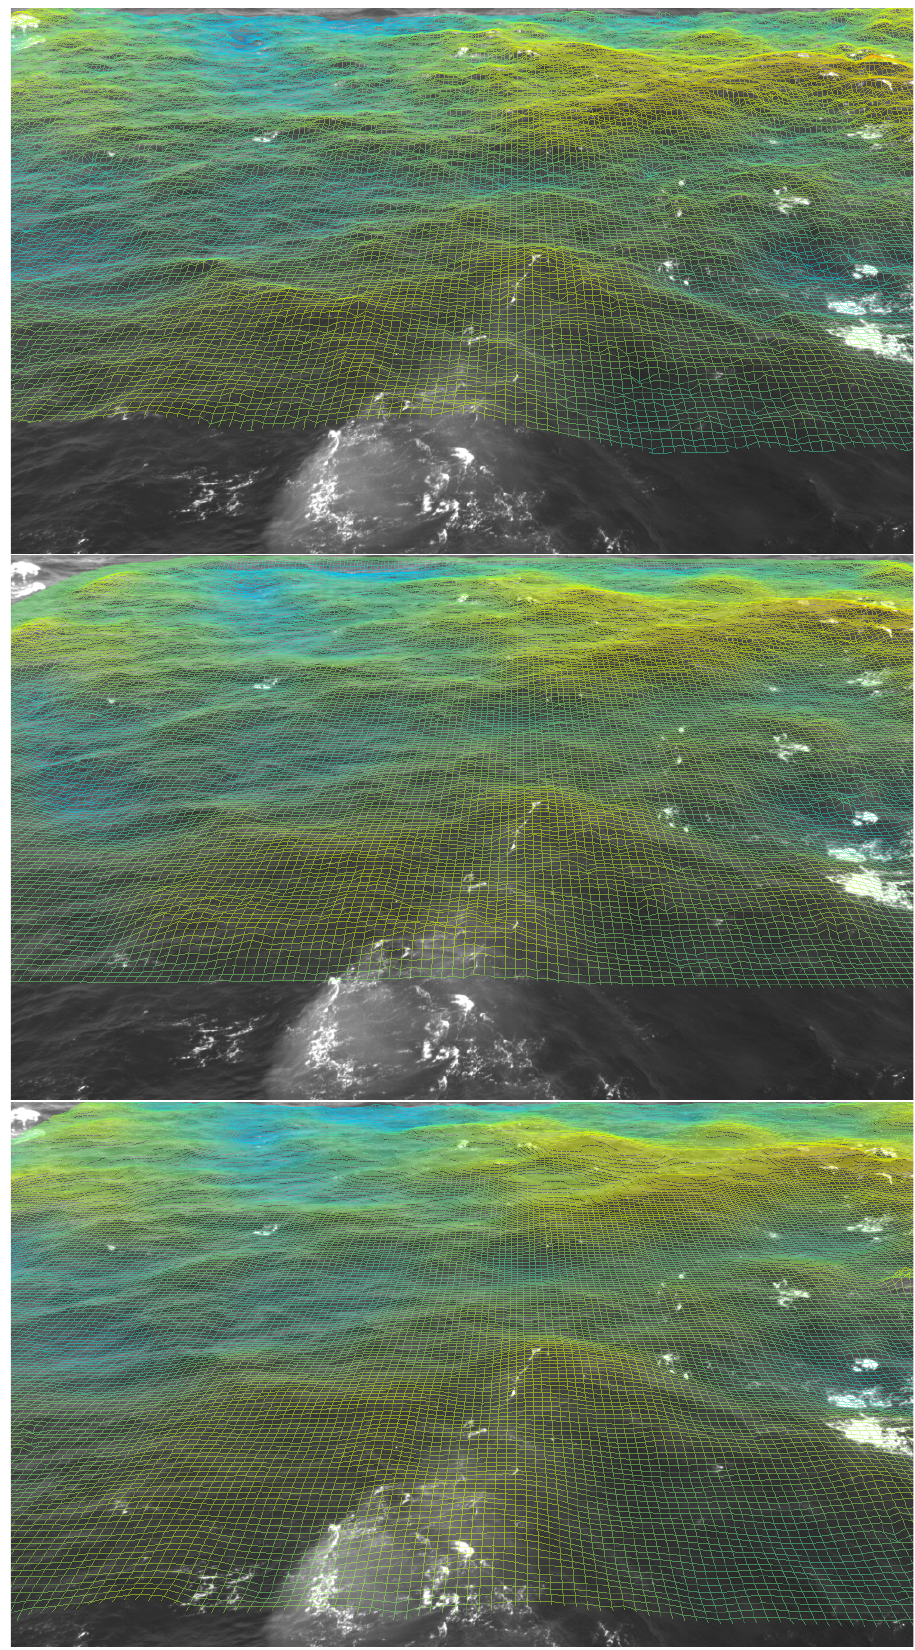
Figure 13. Qualitative comparison of the surface grid reconstructed by WASS ( Top ) and WASSfast PU ( Mid ) and WASSfast CNN ( Bottom ) for record